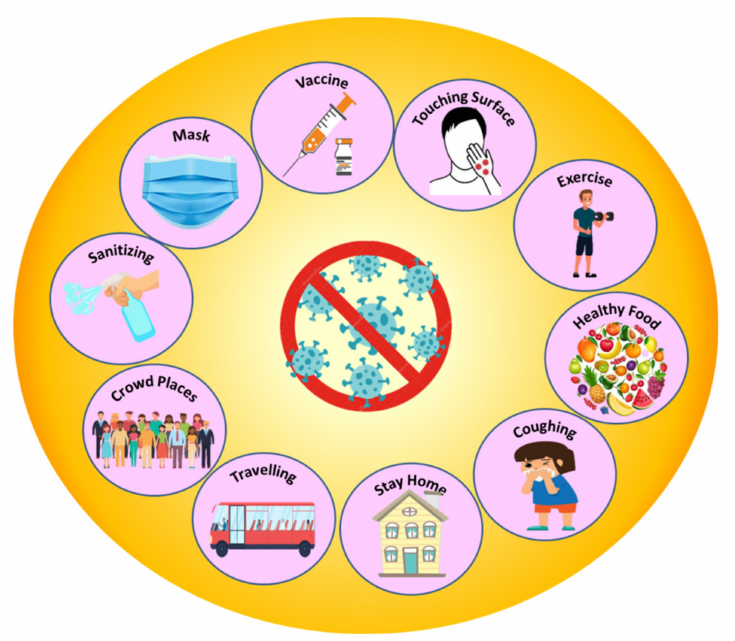
Figure 3. Present methods for controlling the spread of communicable